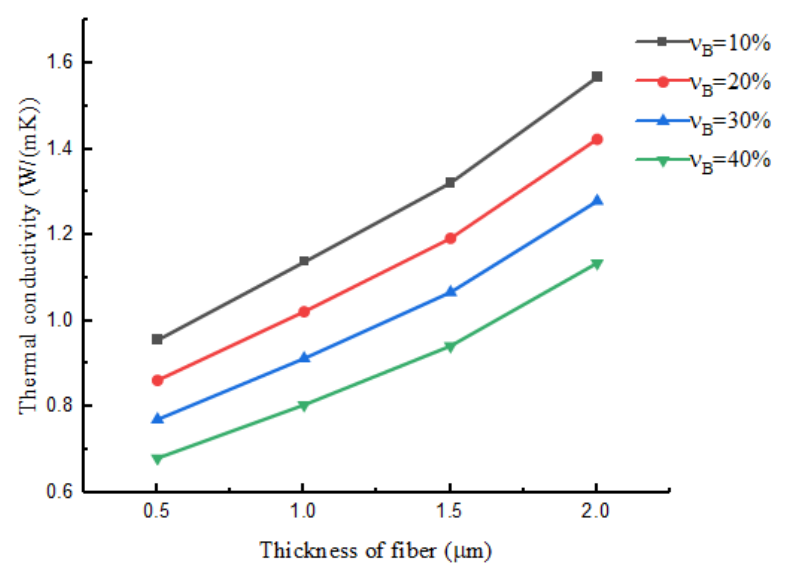
Figure 7. Predicted effective thermal conductivities with different volume fractions of HGBs and thicknesses of hollow fiber.